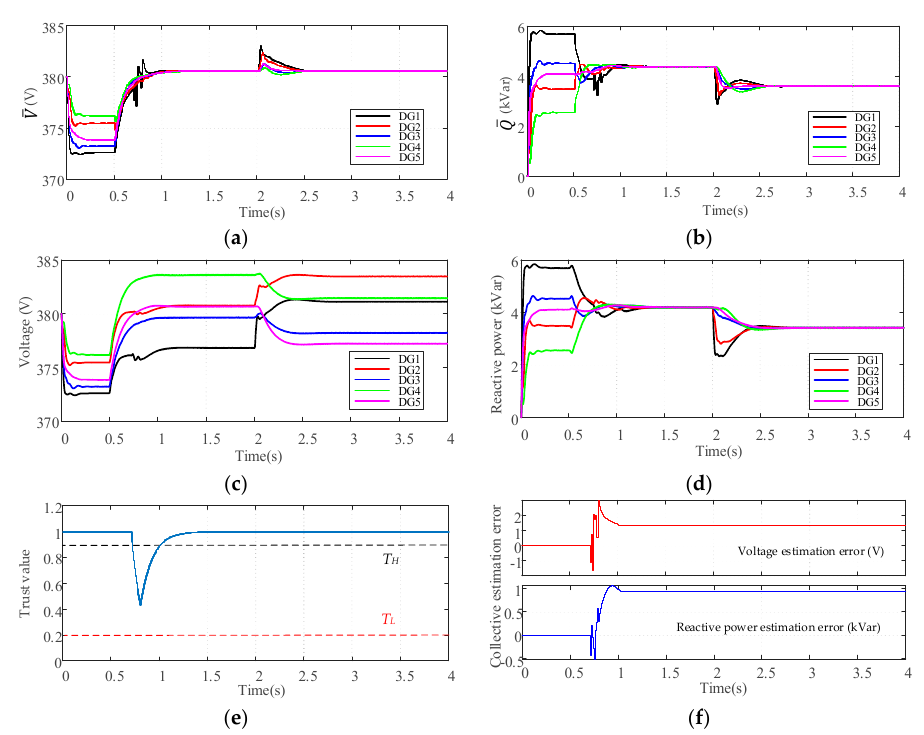
Figure 7. Performance of the control scheme only with the discarding information mechanism: ( a ) Average voltage estimates; ( b ) Average reactive power estimates; ( c ) Voltages of DGs; ( d ) Reactive power of DGs. ( e ) Common trust value of DG1; ( f ) Collective estimation error.